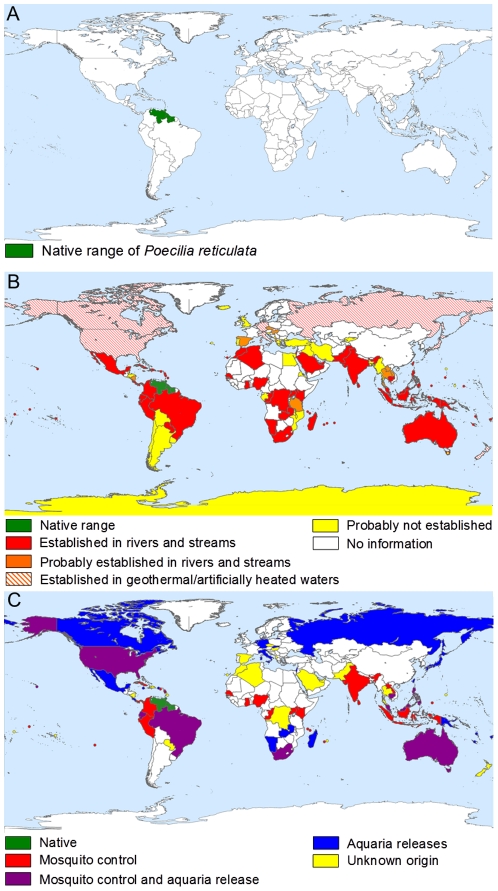
Global distribution and origins of Poecilia reticulata including (A) their native distribution compared with (B) their distribution as a result of introductions and (C) reported reasons behind introductions.Includes records from online databases and published literature, in combination with questionnaire responses. Countries are filled on the basis of reports from at least one location within the country and it should not be inferred that guppies are necessarily present or absent throughout. Coloured dots have been used where necessary to represent data for small islands. Maps were constructed using Manifold (v.8).